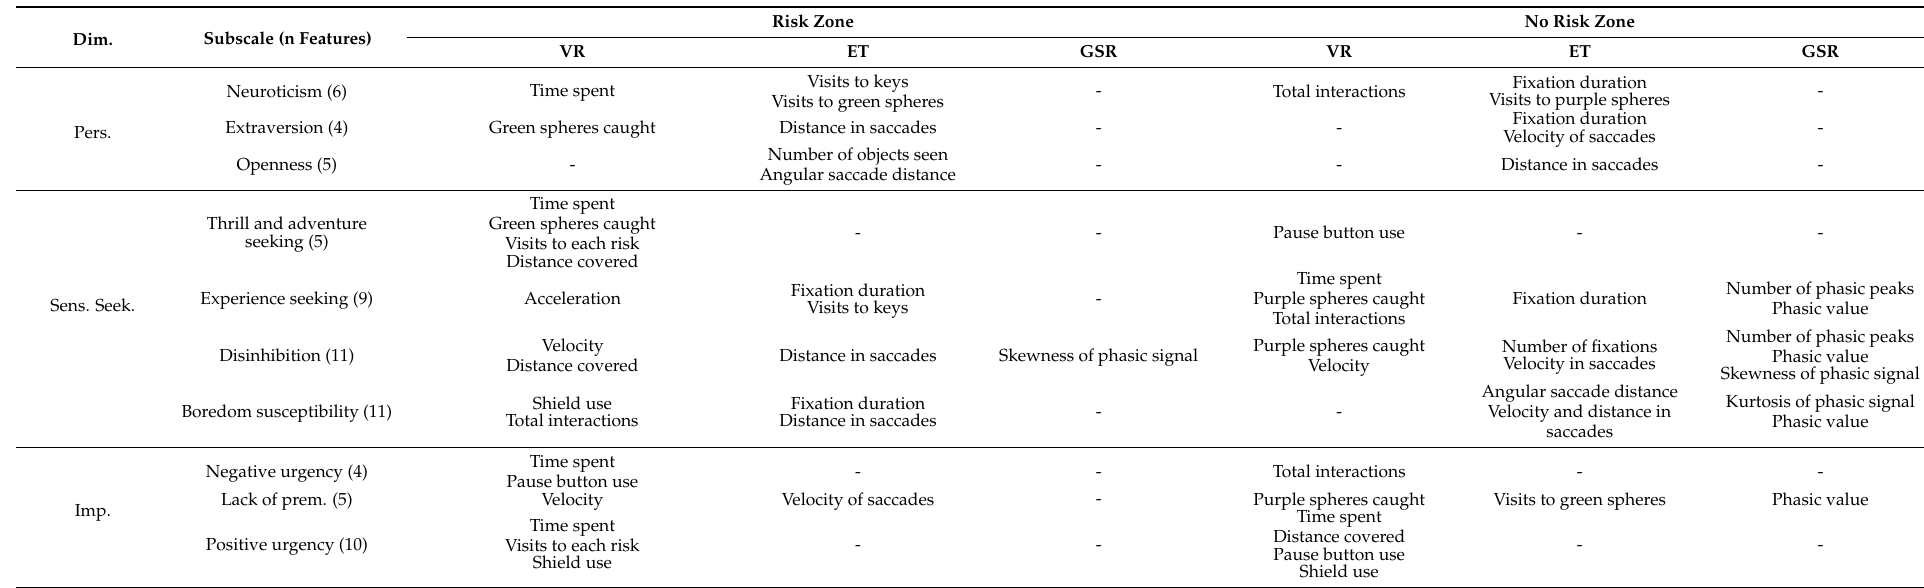
Table 5. Selected features for each classification